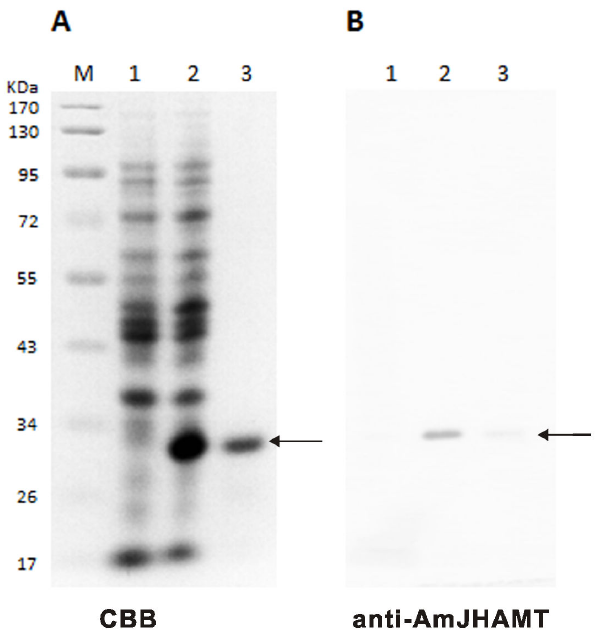
Figure 3. Preparation of the recombinant AmJHAMT protein expressed in E. coli . (A) Coomassie brilliant blue (CBB) staining of recombinant AmJHAMT. Samples were: lane 1 (negative control), crude supernatant from BL21(DE3)/ pET28a (empty vector); lane 2, crude supernatant from BL21(DE3)/pET28a(+)/AmJHAMT; and lane 3, recombinant AmJHAMT (marked by arrow) purified from the product shown in lane 2. (B) Western blotting using polyclonal anti-AmJHAMT antibody. Samples are the same with A. Arrow indicates the recombinant AmJHAMT. M shows the protein ladder and the molecular weight of its single band is listed on the